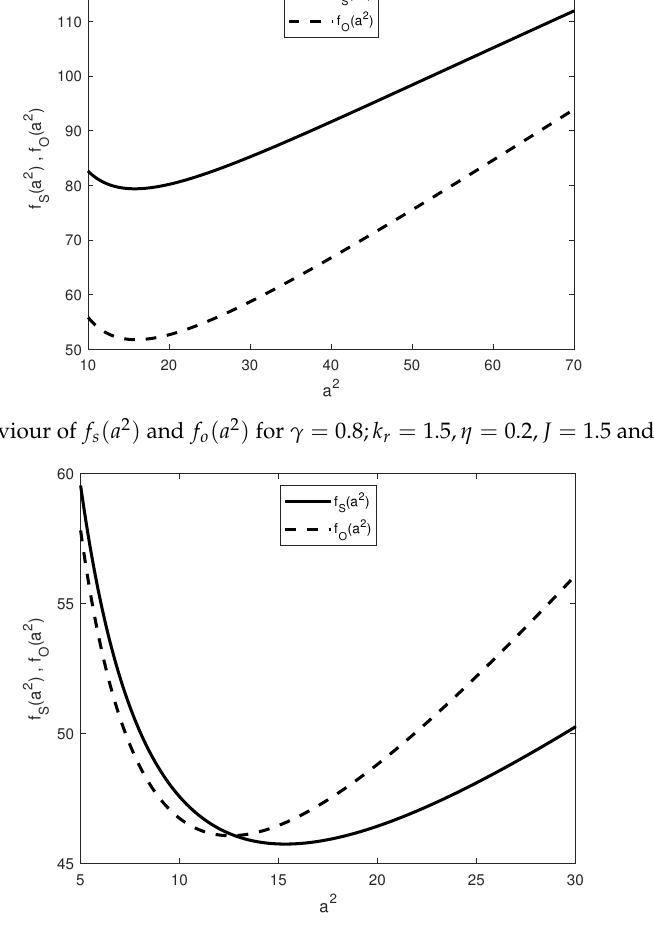
Figure 6. Behaviour of f s ( a 2 ) and f o ( a 2 ) for γ = 0.8; k r = 1.5, η = 0.2, J = 1.5 and T 2 = 7.1.